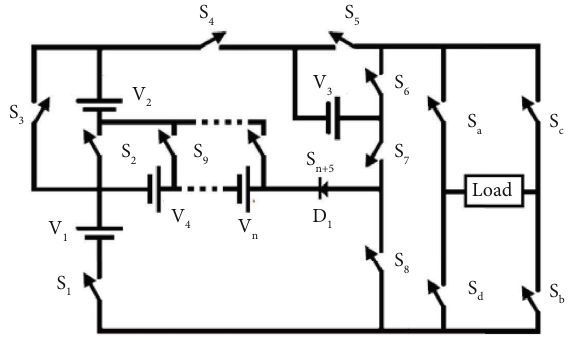
Figure 1: Generalized structure of proposed multilevel inverter topology.